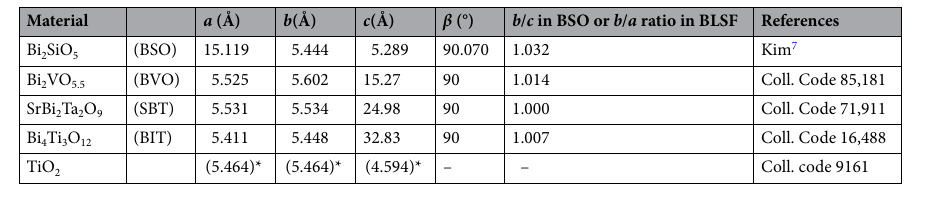
Table 1. Lattice constants of BSO and BLSFs. *In-plane O–O length of (101)TiO 2